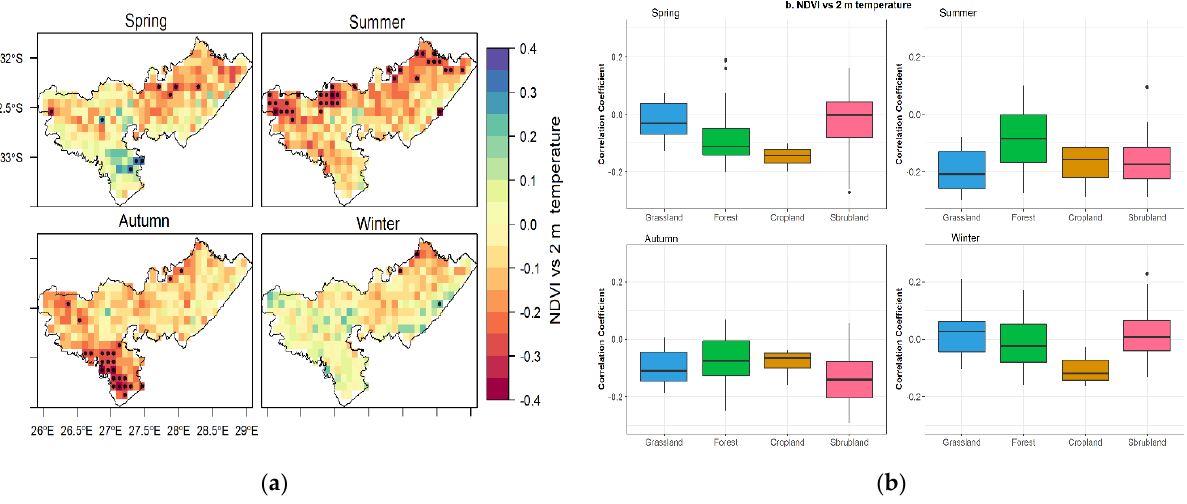
Figure 5. ( a ) Pixel-wise partial correlation coefficients between the NDVI3g and the ERA5-Land 2 m temperature for Amathole District Municipalities; and ( b ) boxplots of the correlation for vegeta- tion types. The stipplings are for pixels with statistical significance ( p -value <